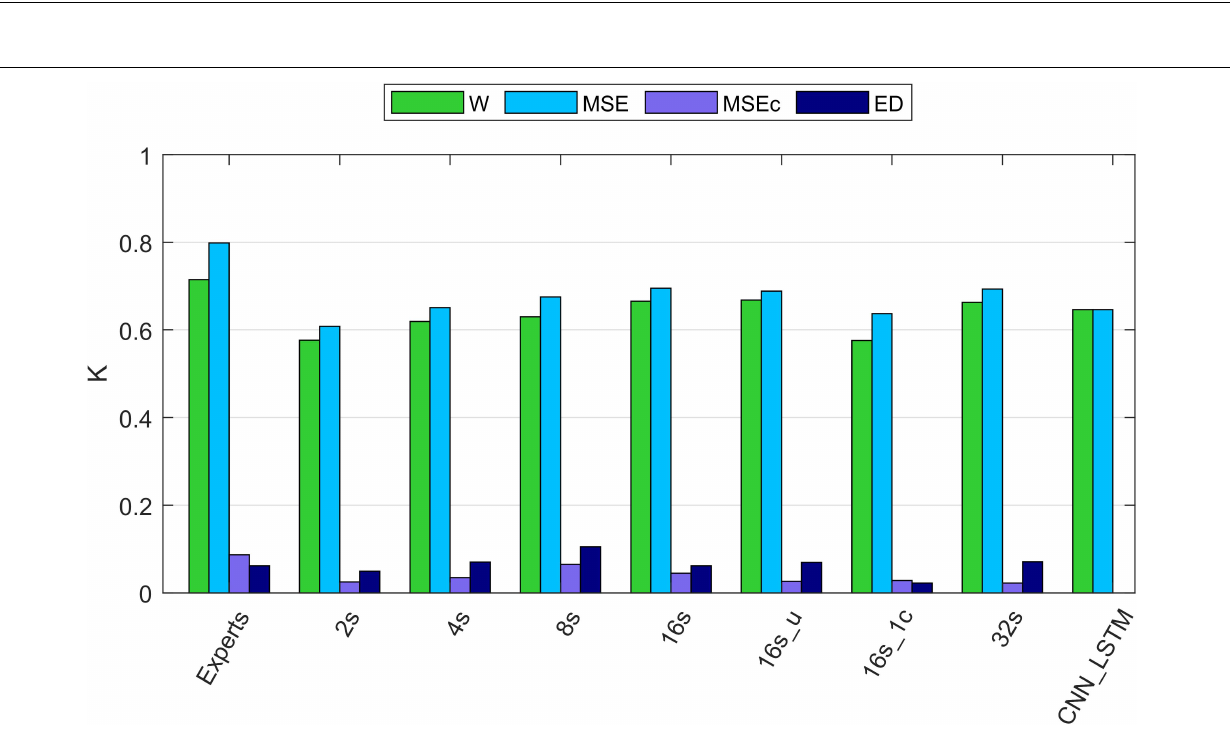
Frontiers in Neuroscience |